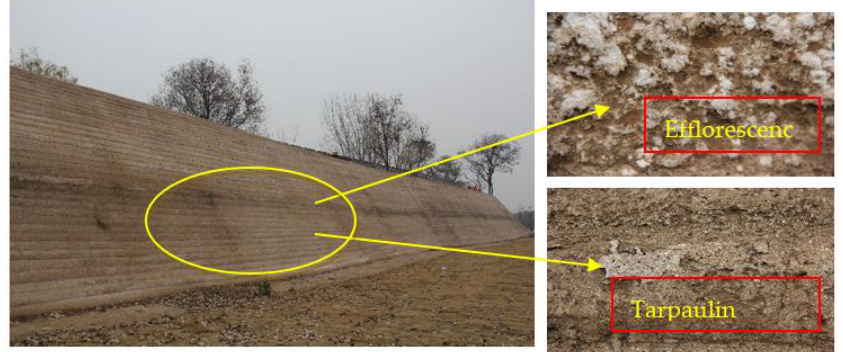
Figure 1. Deterioration of the Kaifeng City Wall.